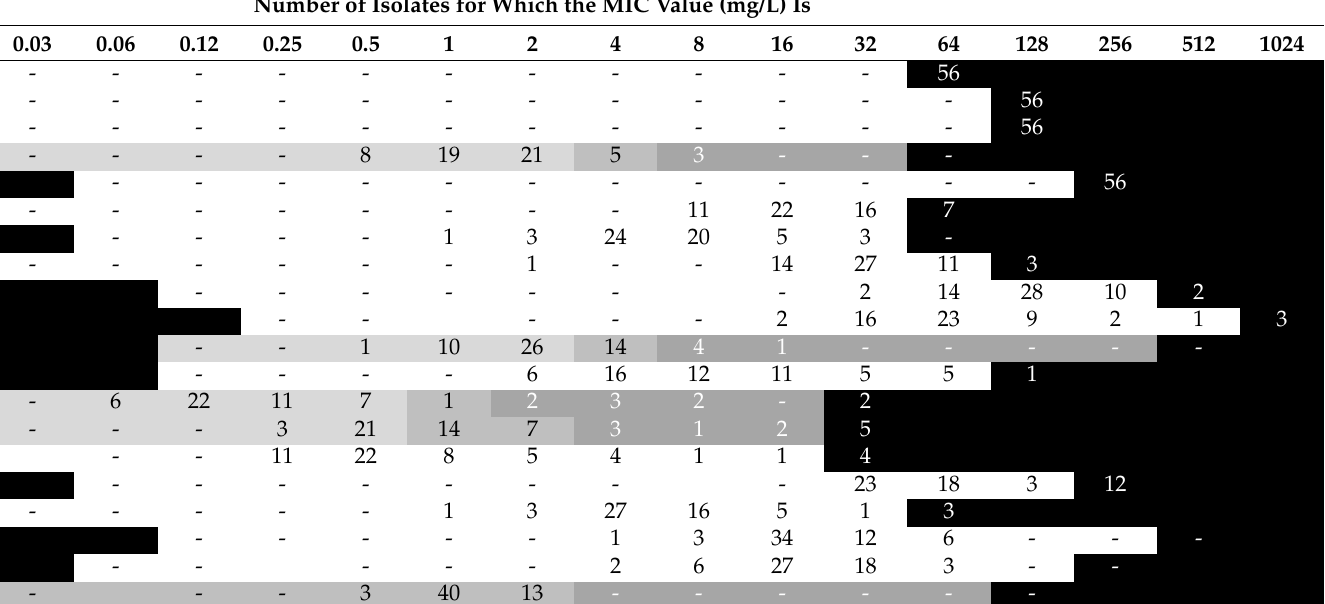
Table 4. Minimal inhibitory concentrations of the 56 canine and feline P. aeruginosa isolates. Antimicrobial Agent